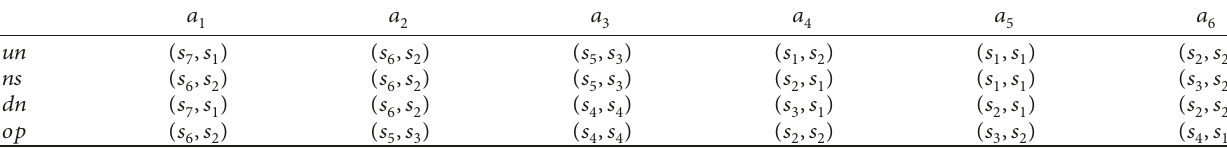
Table 1: Decision matrix by first expert.